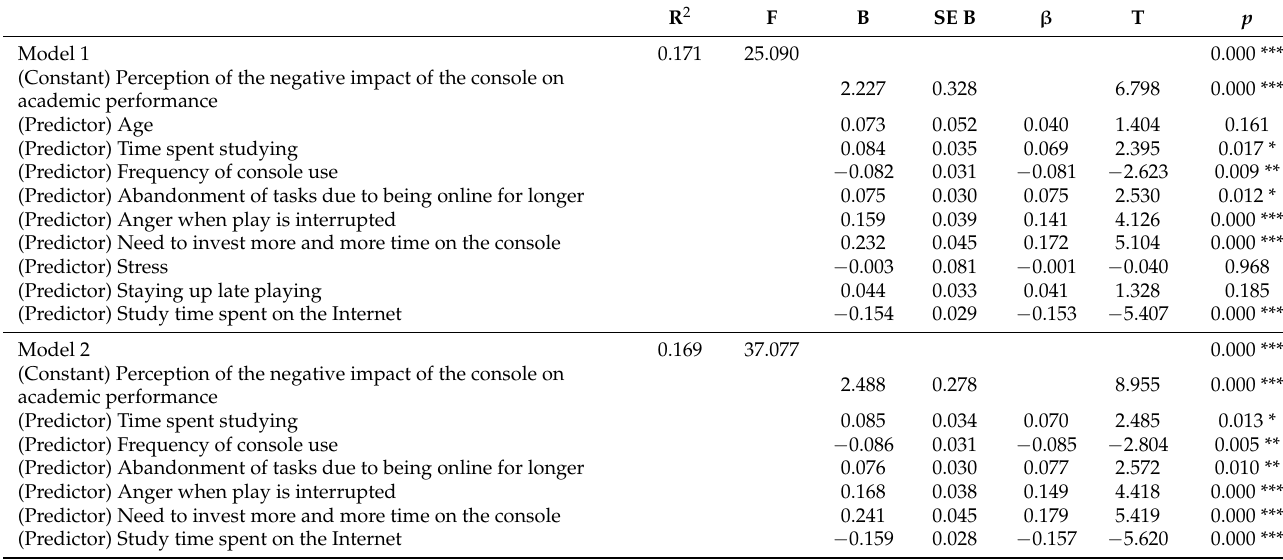
Table 2. Factors that predict the decline in academic performance due to console